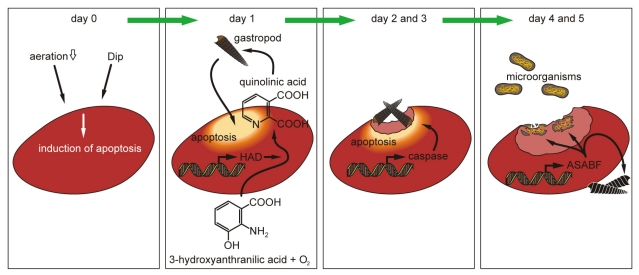
Schematic outline of the elimination of apoptotic tissue from the sponge S. domuncula, after induction with the Fe++ chelator Dip. Initially the expression of the HAD gene is induced as a response to Dip. After initiation of Dip-induced apoptosis the caspase gene is upregulated and, sequentially, the expression of the ASABF gene sets on. While quinolinic acid, a metabolite synthesized via the HAD/kynurenine pathway, attracts the gastropod Bittium sp. the terminally expressed ASABF causes, after removal of the apoptotic tissue, an repelling of the gastropods as well as a killing of the microorganisms.